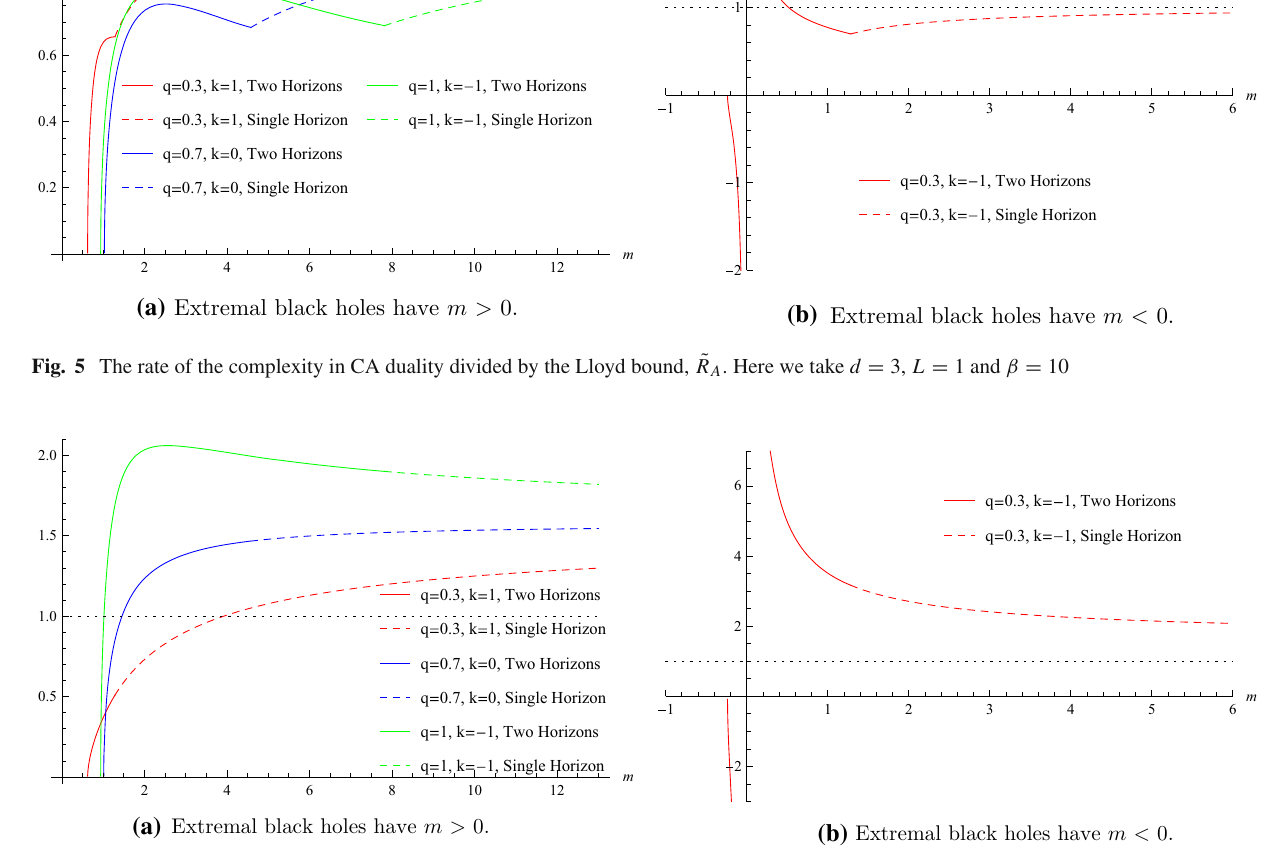
that if an extremal black hole has m > 0, the Lloyd bound is satisfied for the black holes with small enough m but violated for these with large enough m . We plot q = 0 . 3, d = 3, β = 10, L = 1 and k = − 1 in Fig. 6b. If an extremal black hole has m < 0, the Lloyd bound is violated for all or most of the black holes with the same charge as that of the extremal black